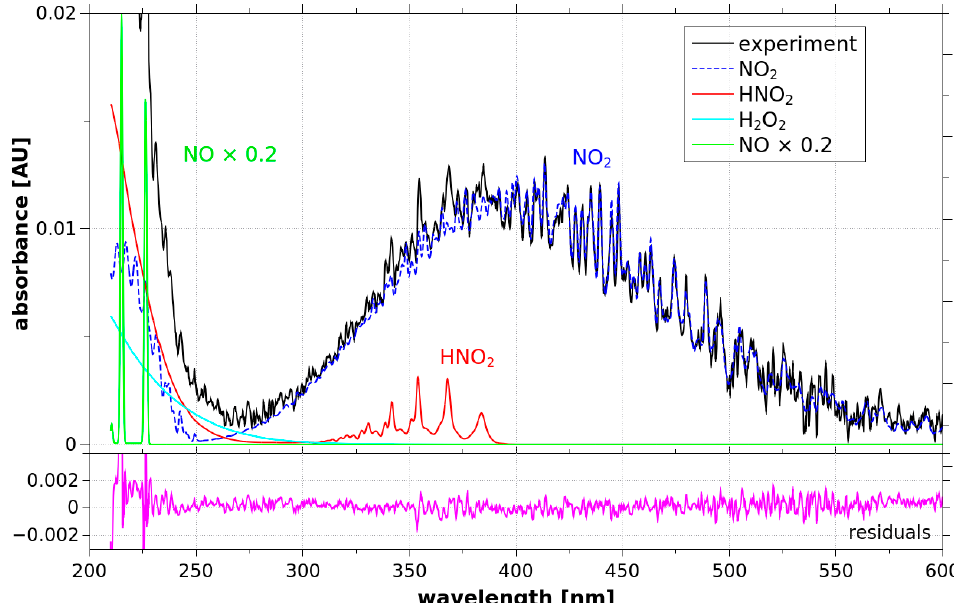
Figure 4. Typical UV-Vis absorption spectrum measured in 10 cm long cell, humid air treated by TS, mean current 2 mA, compared with synthetic spectra of NO 2 , HNO 2 , H 2 O 2 and NO. Bottom chart shows residuals in experimental spectrum after subtraction of all synthetic spectra.